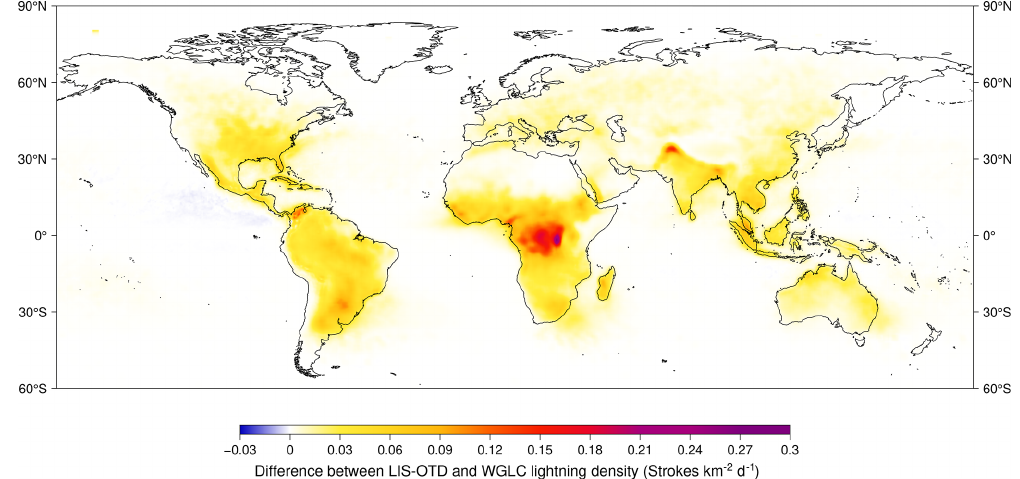
Figure 15. Difference between climatological annual mean lightning density in LIS/OTD (1995–2014) and WGLC